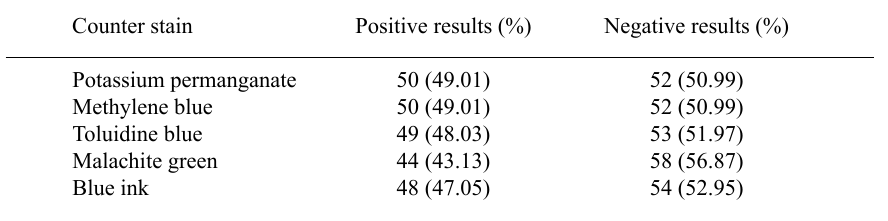
Table 1. Frequency of positive and negative results from sputum specimens